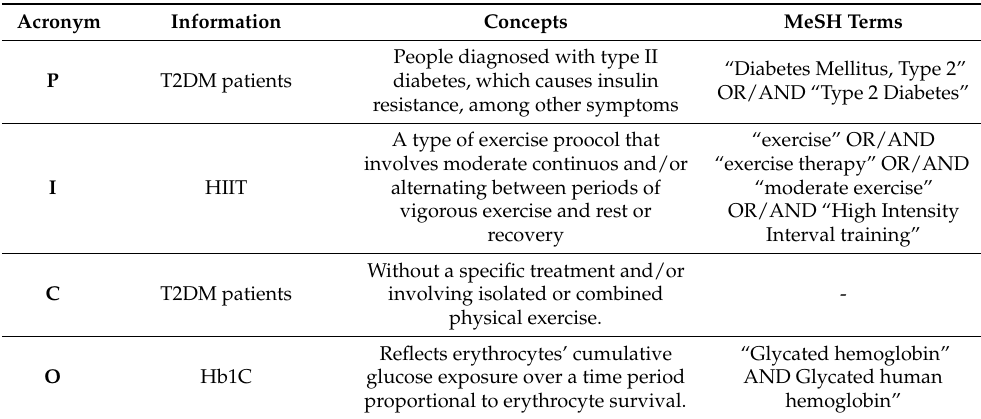
Table 1. Strategy of meta-search using MeSH terms and PICO